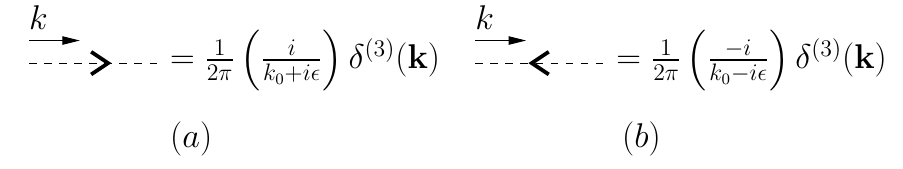
Figure 4 . Propagator connecting ordered pair of vertices; (a) and (b) depicting the two possi- ble